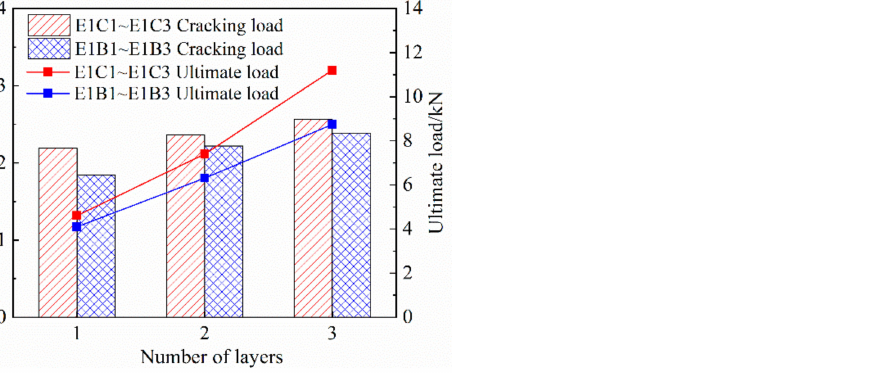
Figure 7. Effect of the number of layers of FRP grid reinforcement on the tensile properties of specimens.